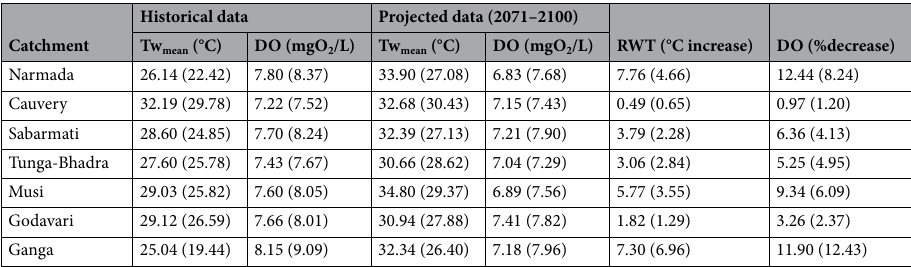
Table 2. The DO concentrations and percentage of DO decrease with respect to monthly average summer and winter (in parentheses) water temperatures for historical and projected (2071–2100) with Representative Concentration Pathway (RCP) 8.5 experiments for seven Indian